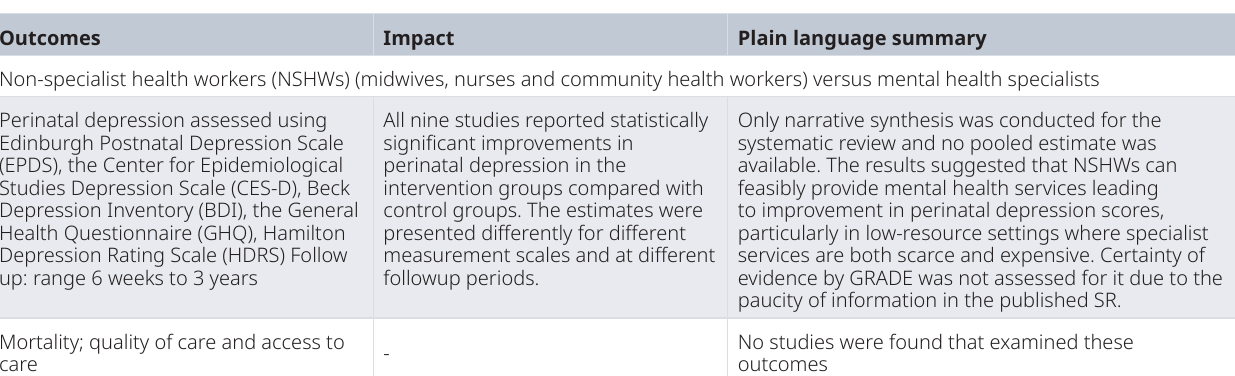
Table 6. Summary of findings for care provided by NSHWs for women with perinatal depression.